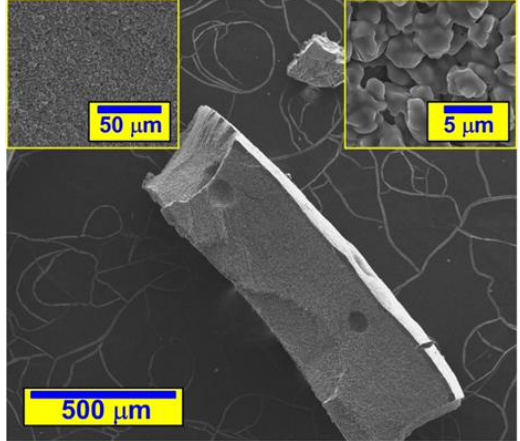
Figure 1. Morphology of NA in the form of CSH nanoseeds (authors’ photo).